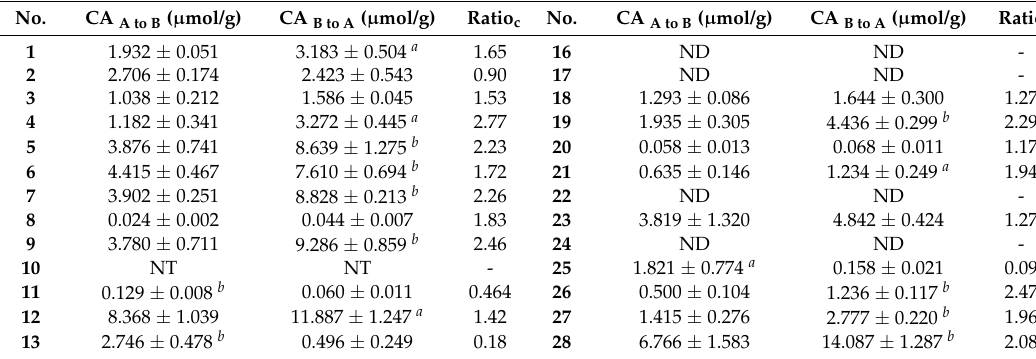
Table 4. The cellular accumulation (CA) of flavonoids in Caco-2